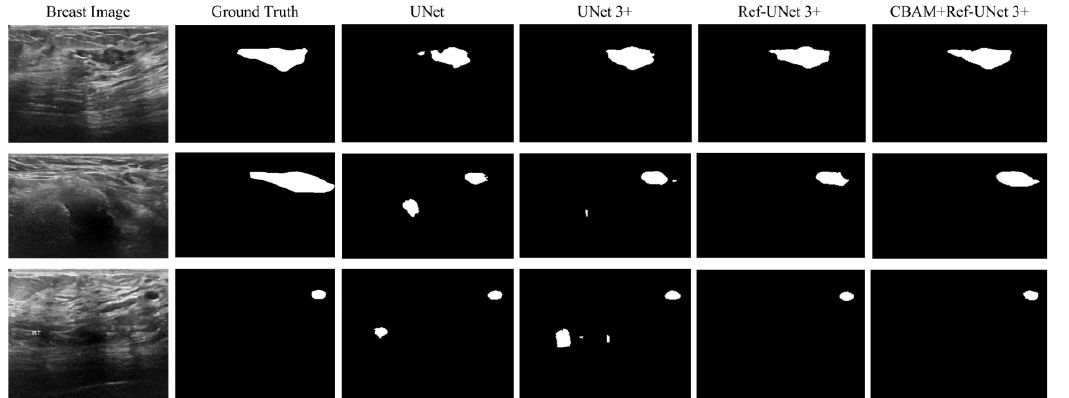
Figure 11. Visualization of breast cancer segmentation results. From left to right: original image, ground truth, segmentation result of Unet, segmentation result of Unet 3+, segmentation result of Ref-Unet 3+, and segmentation result of CBAM+Ref-Unet 3+.